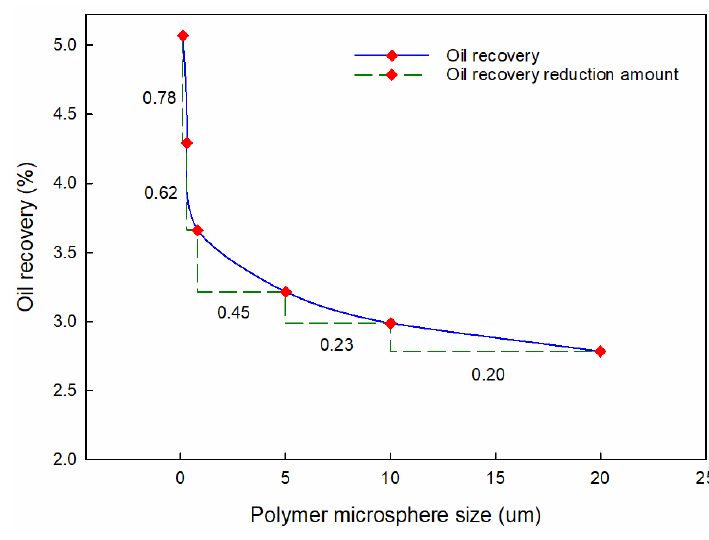
Figure 9. Oil recovery with different sizes of PMs.